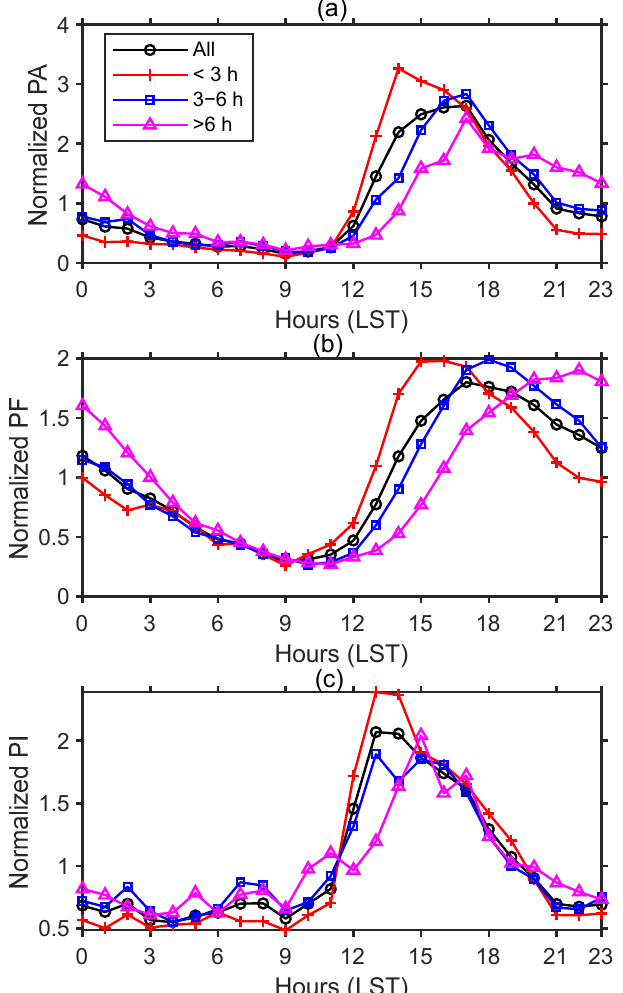
Figure 5. Diurnal variations in PA ( a ), PF ( b ), and PI ( c ) for different rain event durations. PA, PF, and PI values for each hour were divided by the average value.